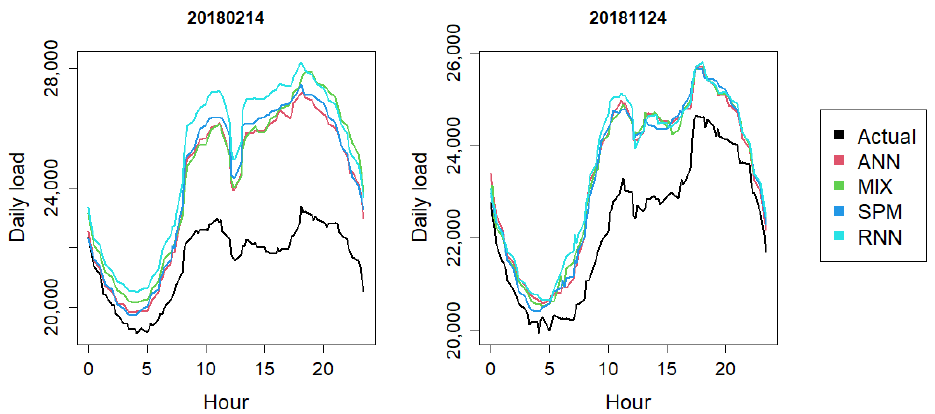
Figure 7. Actual Load and ( D + 1)-day Forecasts for 14 February and 24 November 2018 by the ANN (Artificial Neural Network), Mixed, SPM and RNN Models Made on the Previous D -Day.